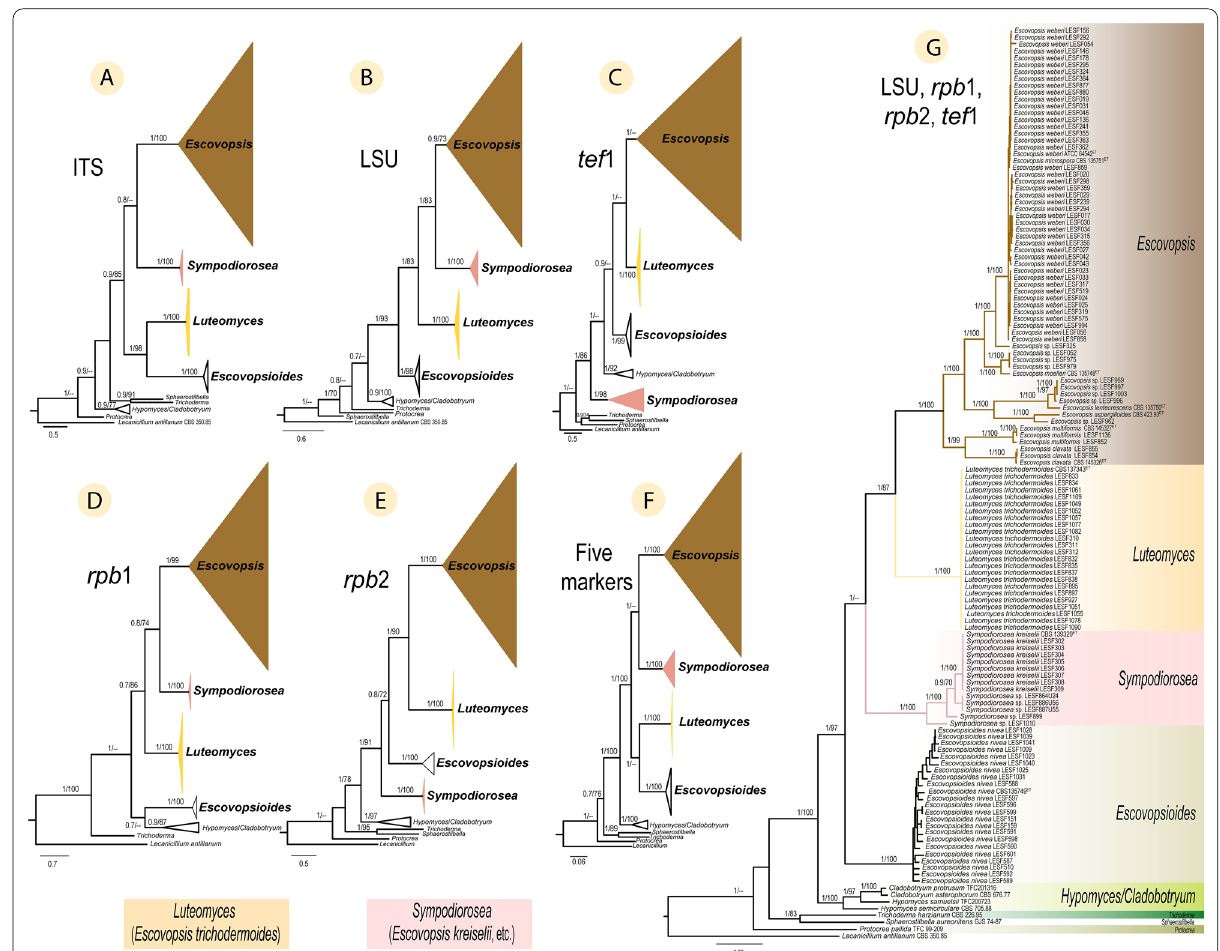
Fig. 3 Phylogenetic placement of Escovopsis , Sympodiorosea and Luteomyces within the Hypocreaceae . Phylogenies shown were inferred using Bayesian Inference (BI) and are separated for each region (molecular marker): ( A ) ITS, ( B ) LSU, ( C ) tef 1, ( D ) rpb 1, and ( E ) rpb 2. The remaining two trees are based on concatenated datasets of ( F ) all five markers, and ( G ) four of the five markers (LSU, rpb 1, rpb 2, and tef 1). Numbers on branches indicate BI posterior probabilities (PP) and Maximum Likelihood bootstrap support values (MLB), respectively. Hyphens (--) indicate MLB < 70%. Lecanicillium antillanum CBS 350.85 was used as the outgroup. ET indicates ex-type cultures. See Table S1 for all strains and their associated metadata used to infer these phylogenetic